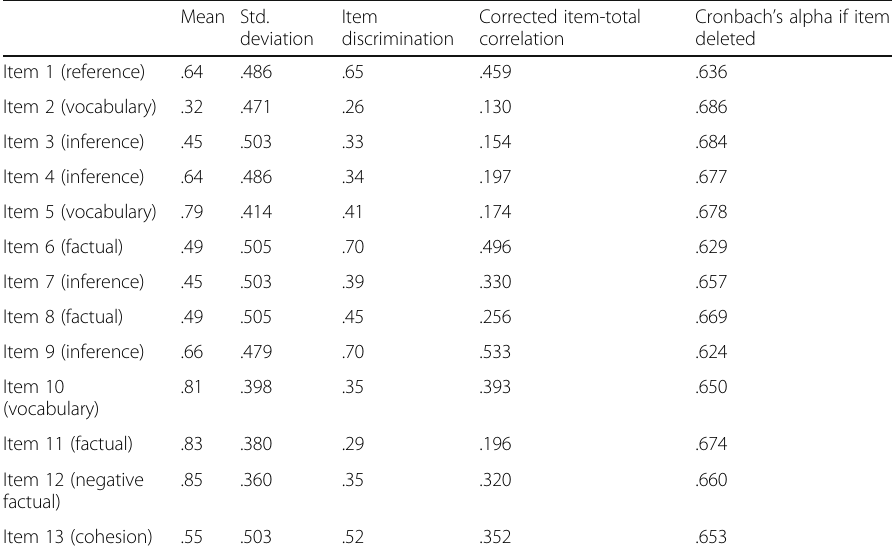
Table 2 Item analysis of the 13 MC reading items ( N = 47, K = 13) Mean Std.